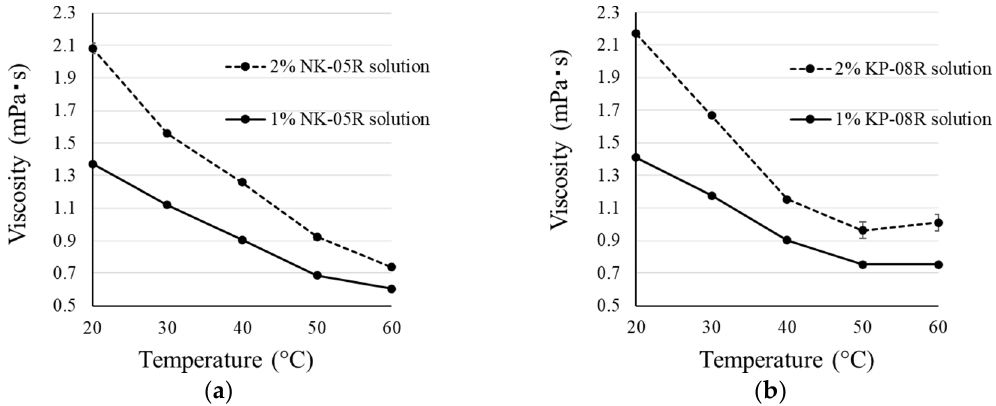
Figure 2. Viscosities of the 1% and 2% PVA solutions plotted against temperature at the measurement: ( a ) NK-05R solution; ( b ) KP-08R solution. Each point represents the mean ± SD ( n = 3).